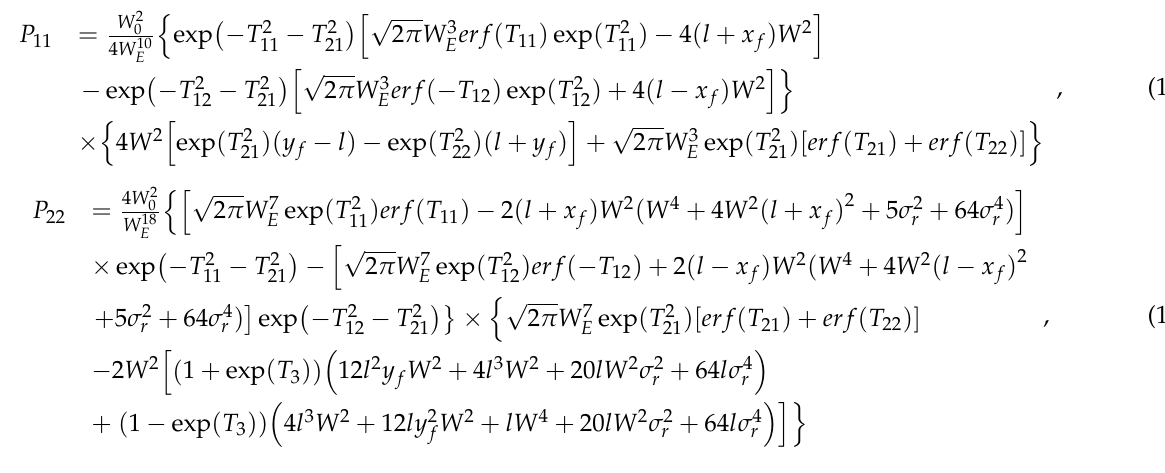
where D denotes the diameter of the circular receiving aperture. However, Equation (16) cannot be integrated over a circular area when the receiving aperture is not located at the center of the main propagation axis. Inspired by [21,22], we use a square within the same area to substitute the circle as the integration area. The square length l is equal to √ 0.5 π D . Assuming that the coordinates of the center of the receiving aperture are ( x f , y f ), Equation (16) can be approximated as